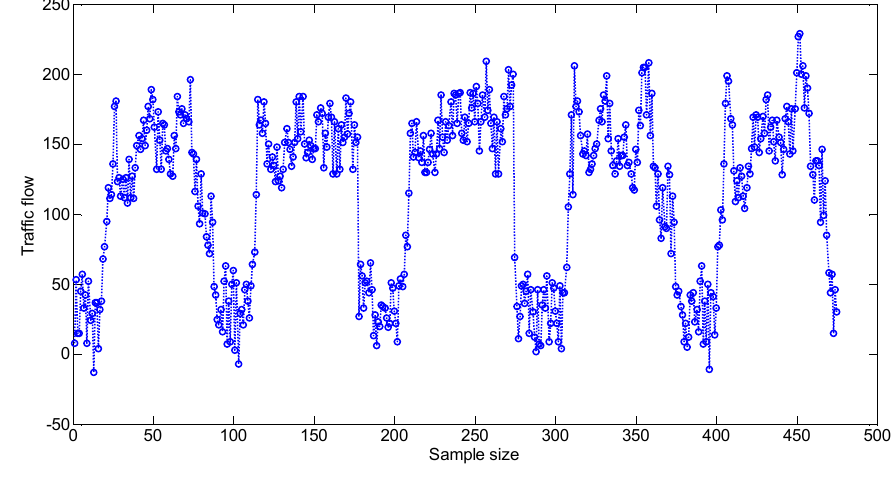
Figure 3. Traffic flow sequence.